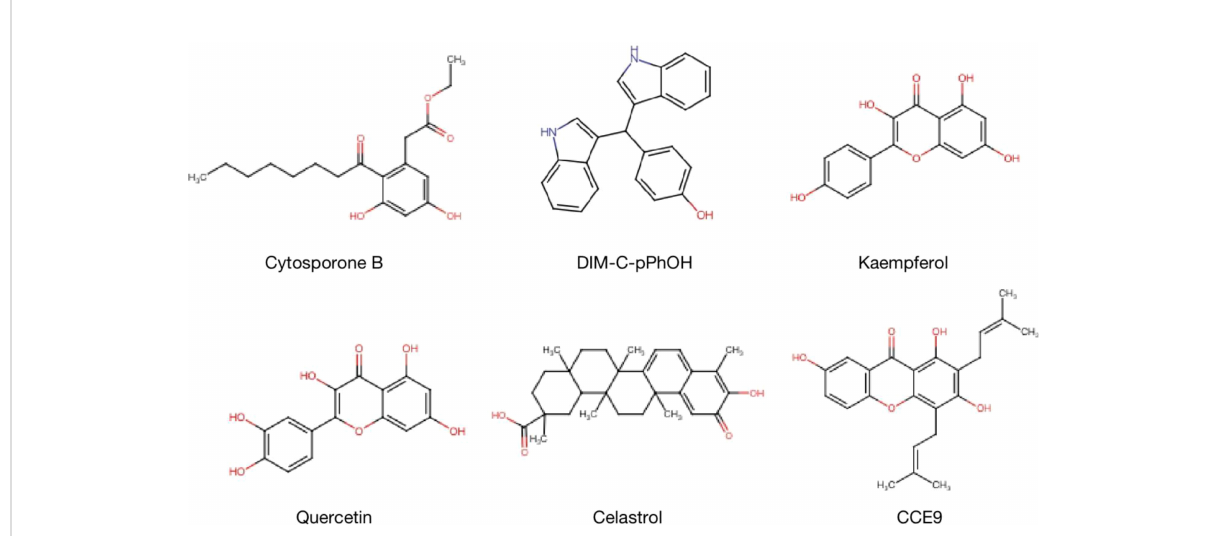
FIGURE 8 Structure of NR4A1 agonists or antagonists. Structure of NR4A1 inducer Cytosporone B, and inhibitors DIM-C-pPhOH, Kaempferol, Quercetin, Celastrol,